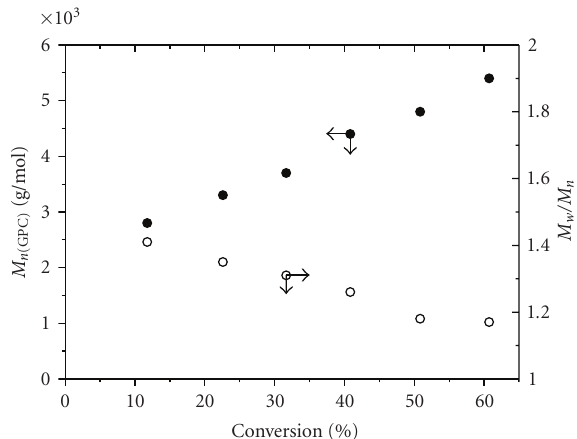
Figure 4: Dependence of molecule weights and molecule weight distributions on monomer conversions for RAFT copolymerization of HQHEMA and St. Polymerization condition are the same as in Figure 3.